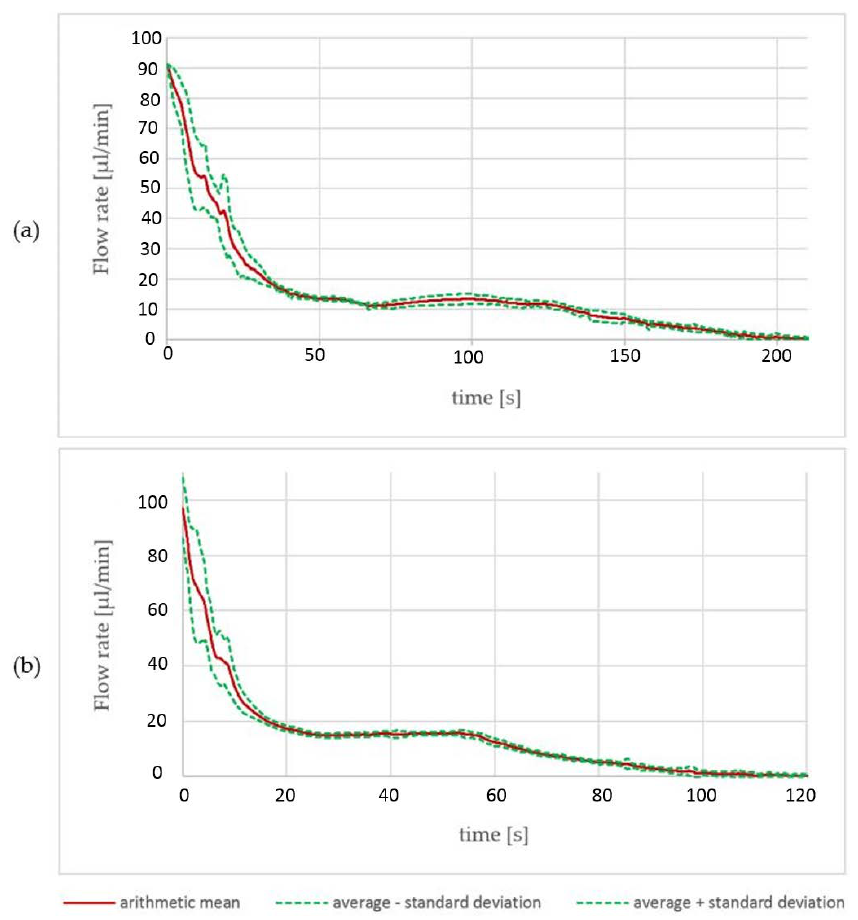
Figure 5. Data achieved by the pump characterization process of ( a ) 45 µ L reservoirs and ( b ) 25 µ L reservoirs. Each graph shows the arithmetic mean of the measured flow velocity achieved by an electrolysis reaction. The failure tube is formed by the standard deviation of 13 reservoirs with a volume of 25 µ L and eight reservoirs with a volume of 45 µ